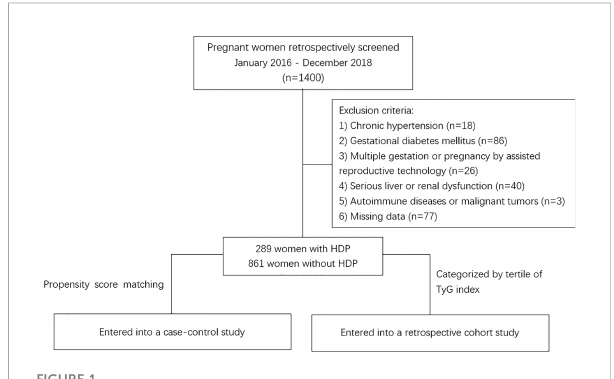
FIGURE 1 Flowchart of the study. HDP, hypertensive disorder of pregnancy; TyG, Triglyceride –